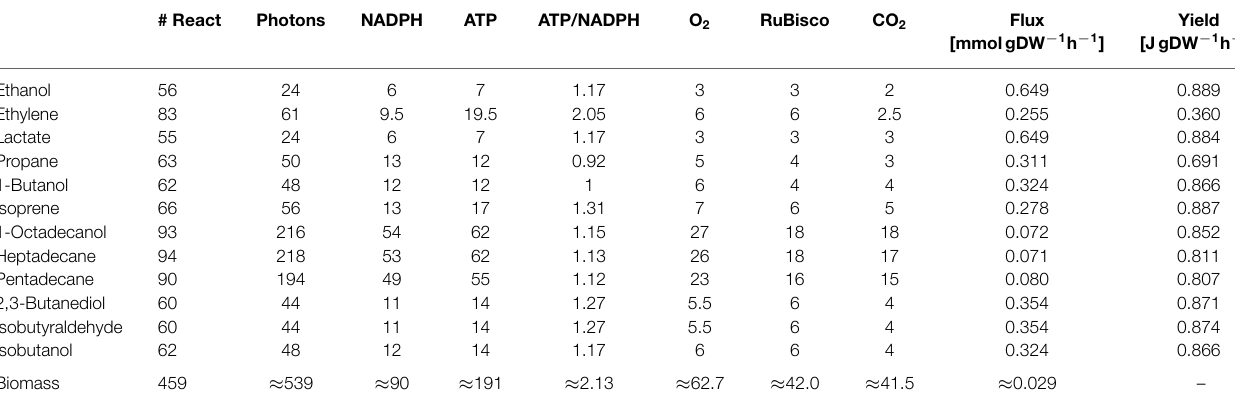
TABLE 1 | Stoichiometric properties of cyanobacterial biofuel synthesis